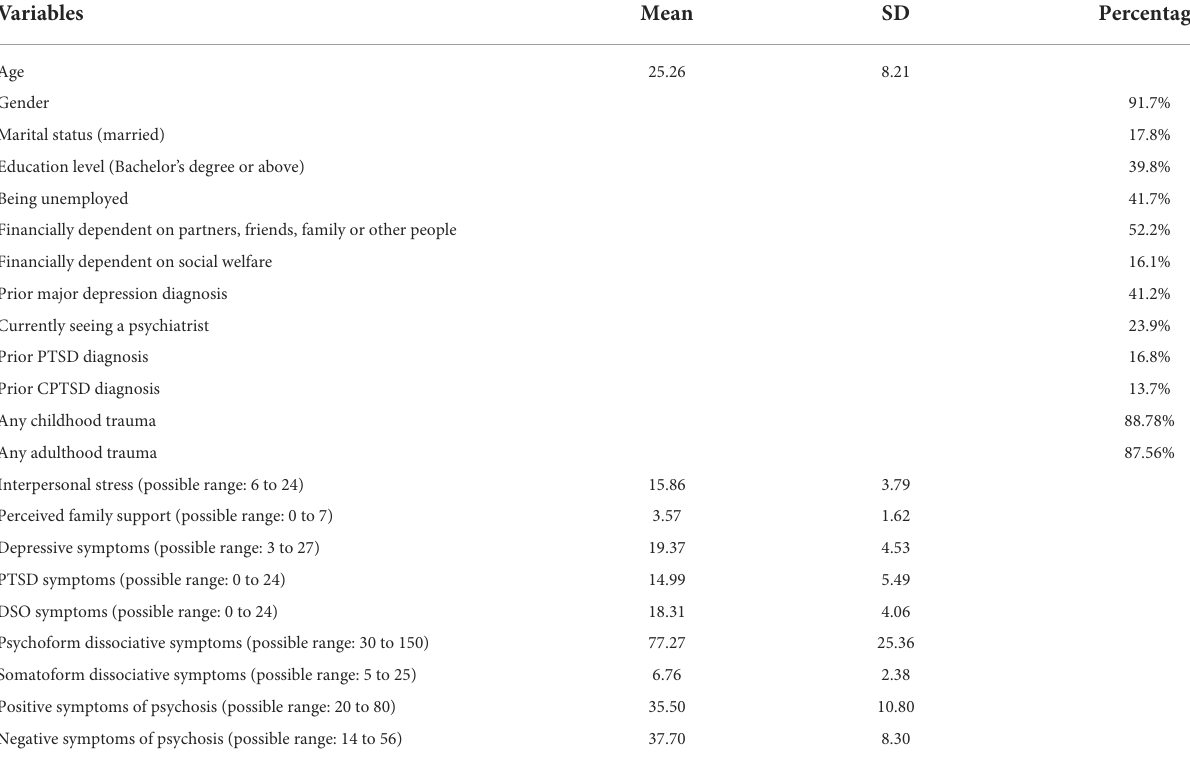
TABLE 1 Sample characteristics (N =